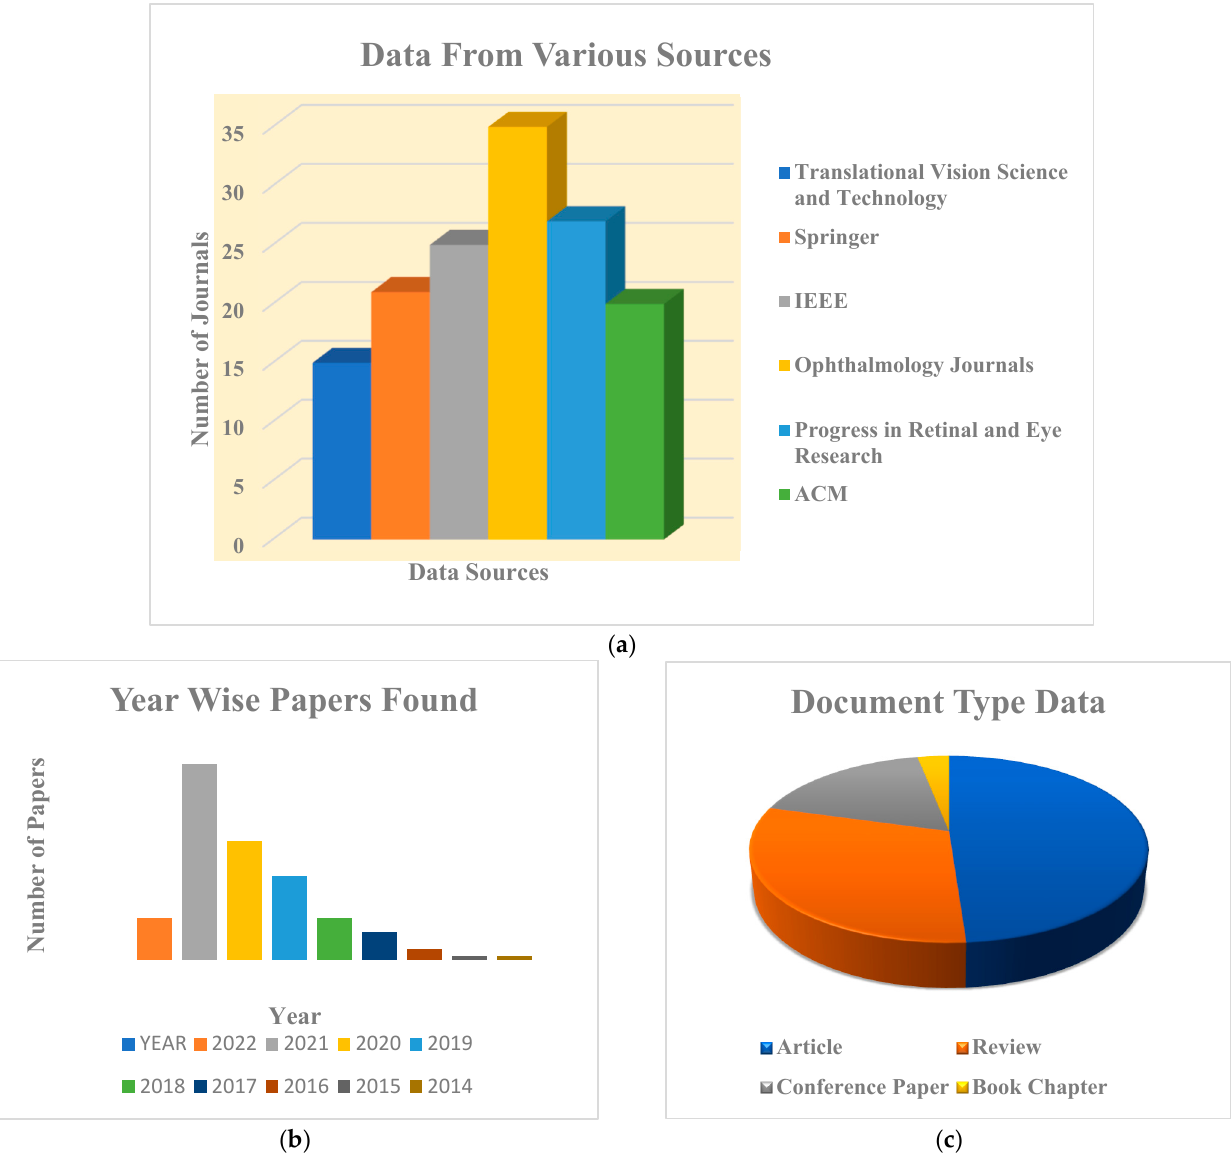
Figure 8. Relevant paper distribution based on ( a ) Data Source, ( b ) Year, and ( c ) Document